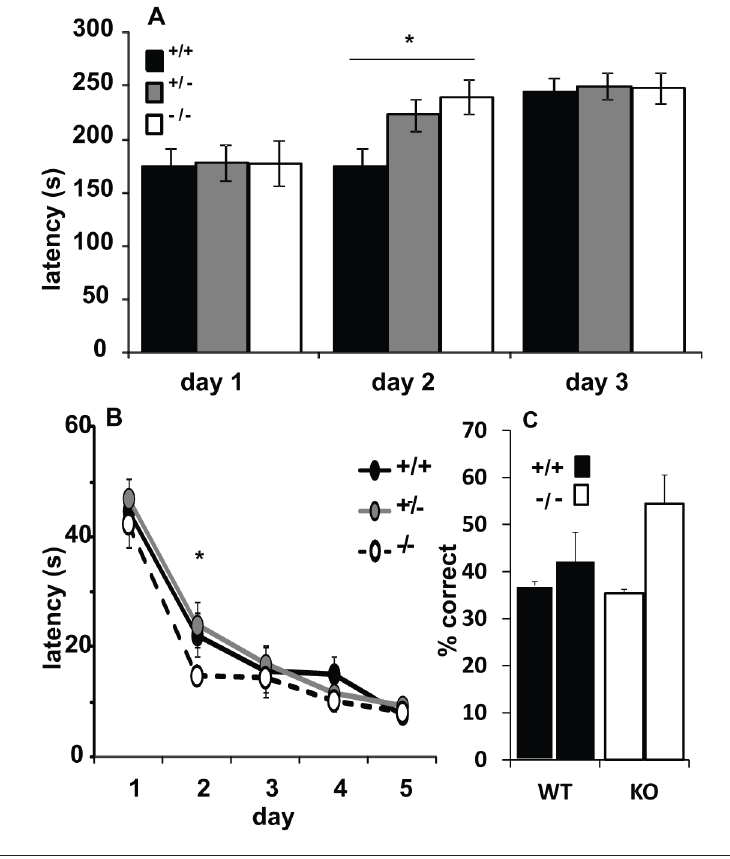
Figure 2. Acquisition and performance of the rotorod (A) Morris water maze (B) and 5-choice serial reaction time (C) tasks in constitutive CDH13 knockouts and wild-type littermates. (A) Mean ± SEM of the latencies to fall from the accelerating rotorod in wild-type, heterozygous and homozygous constitutive CDH13 knockouts. Knockouts showed faster acquisition of the task (repeated measures ANCOVA, p = 0.040). N = 24/genotype. * p < 0.05. (B) Mean ± SEM of the latencies to reach Morris water maze platform for wild-type, heterozygous and homo- zygous CDH13 knockouts. Knockouts displayed no significant deficit in task acquisition (days 1–5, repeated measures ANOVA genotype*day effect, p = 0.96), and displayed better per- formance on d 2 of testing when compared with mice of both other genotypes * p < 0.05. (B) Mean ± SEM of the probe trial results. (C) Mean ± SEM of % correct responses in 5-choice serial reaction time testing in the first 2 trials of this task in male mice. Knockouts showed a trend toward faster acquisition of the task that did not achieve significance ( p = 0.1). Females failed to display any trends (data not